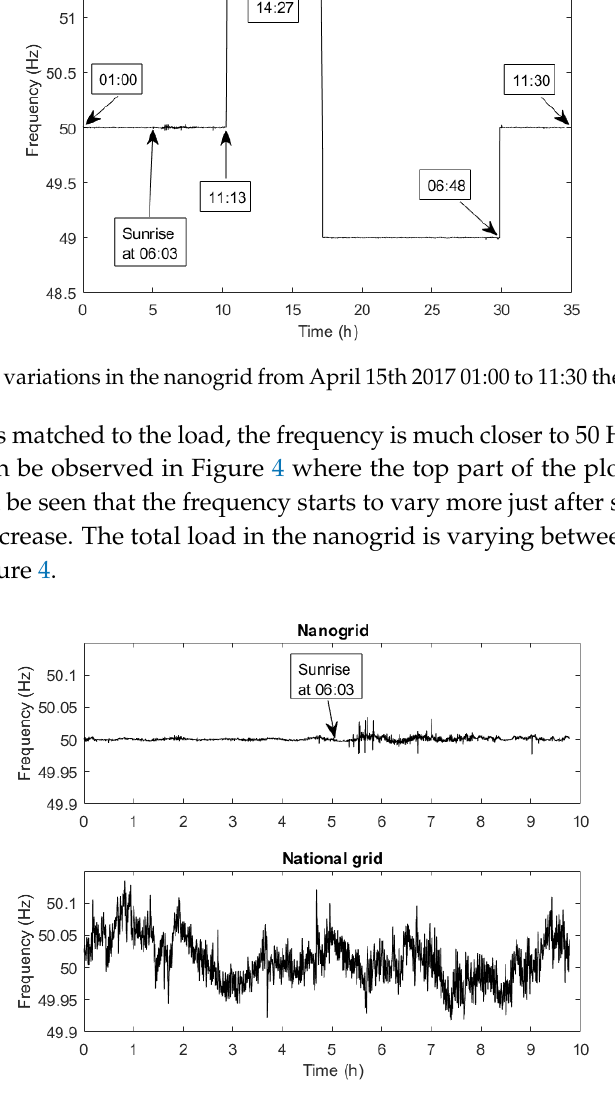
Figure 4. Enlarged view of the frequency variations in the nanogrid from Figure 3 ( top ) and frequency in the Swedish national grid ( bottom ) during the same period of time.